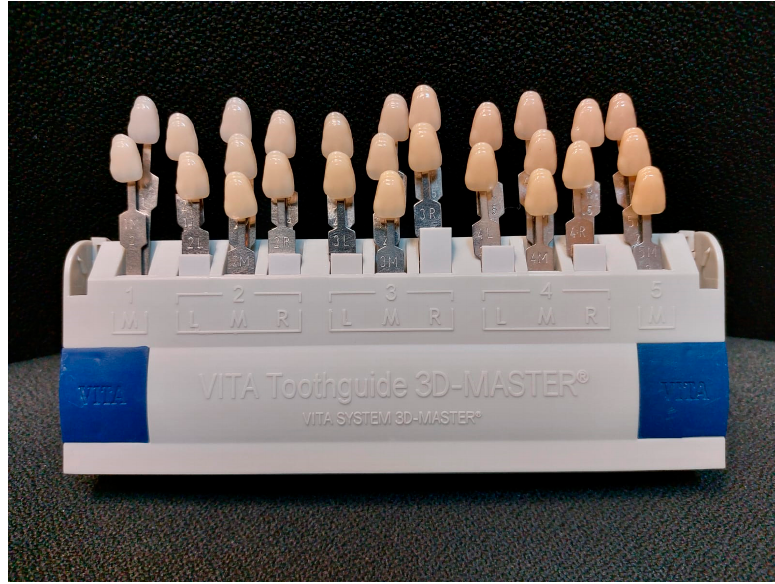
Figure 4. Vita 3D Master Shade Guide.